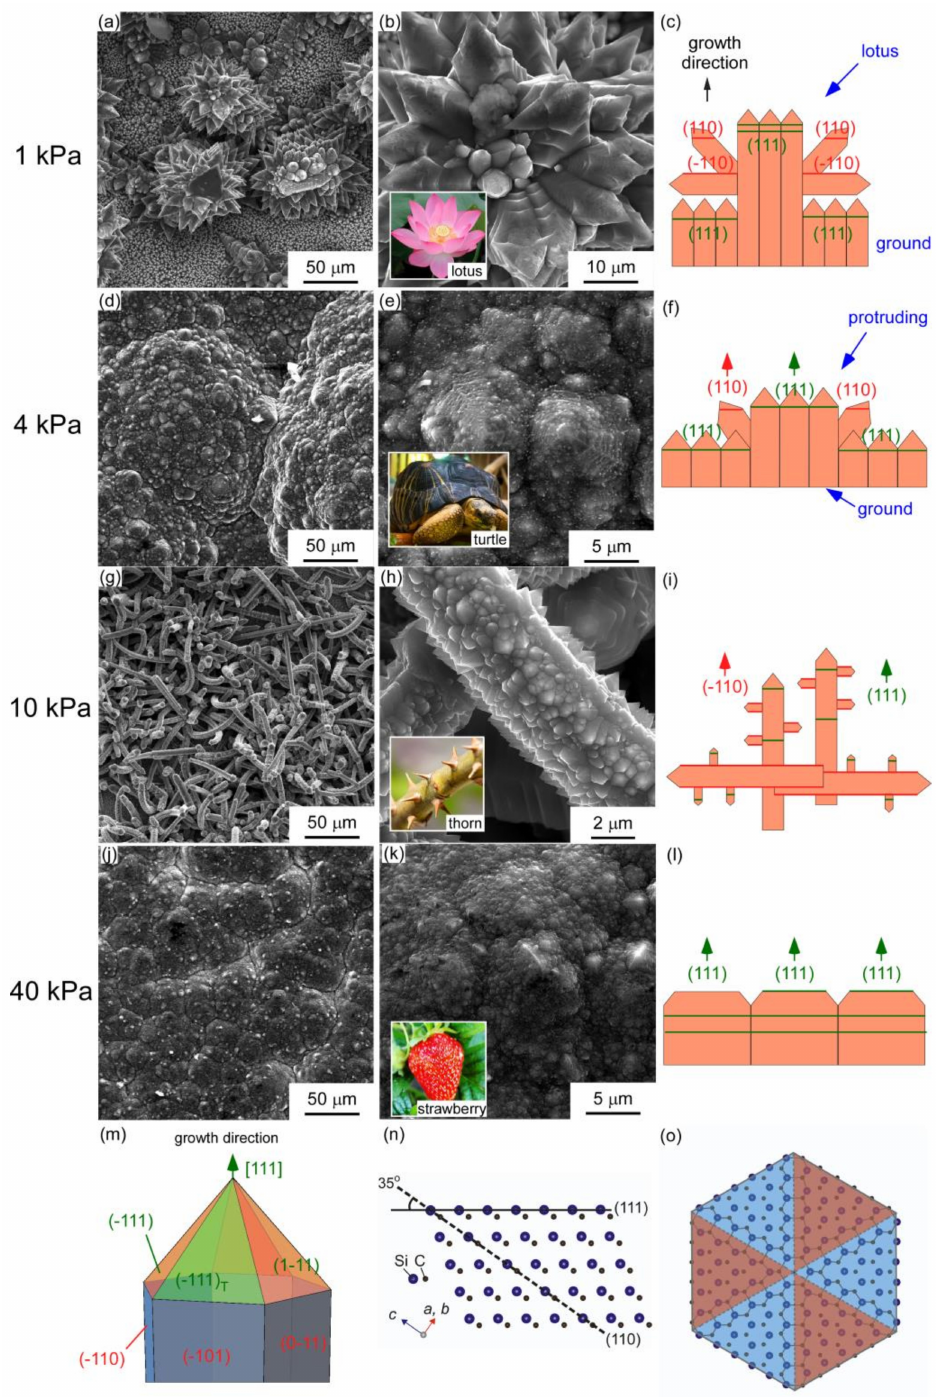
Figure 4. Surface and cross-section morphology of 3C-SiC films prepared at T dep of 1673 K, P tot of ( n ) Schematic diagram of the relationship between the (110) and (111) planes in 3C-SiC lattice; ( o ) the hexagon growth of 3C-SiC (111)